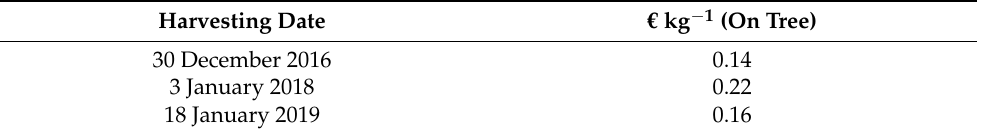
Table 3. Average prices of citrus fruit “Navel Foyos” at the corresponding harvesting dates for each trial season in Valencia